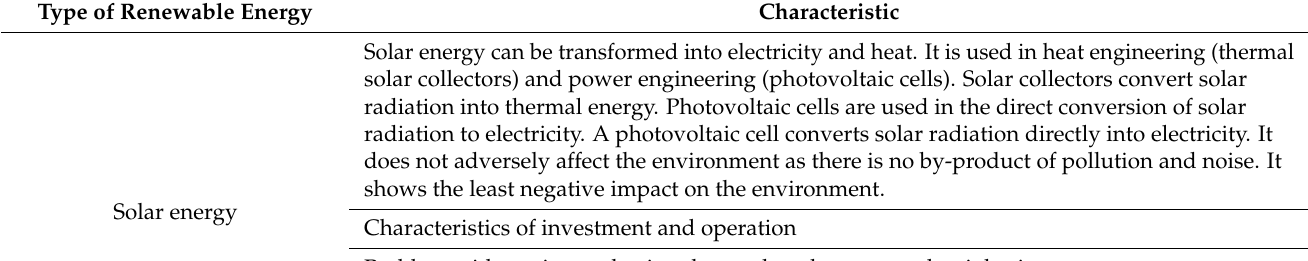
Table 1. Characteristics of renewable energy